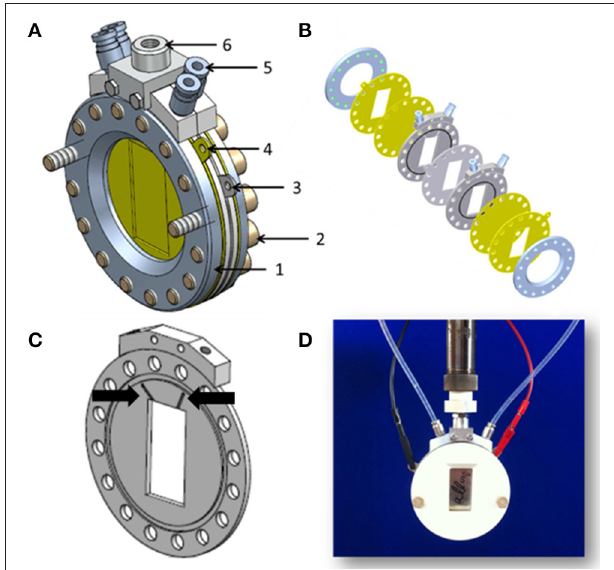
FIGURE 1 | (A) Expanded view of the in-situ cell; 1 and 2 correspond to the alloy clamp rings and PEEK screws used to seal the cell after assembly, 3 and 4 are the two windows which hold the thin Ni metal sheets used as positive and negative electrodes, 5 are inlet/outlet connections for the tubing to pump in gas fuel or electrolyte and 6 is the threaded block used to mount the cell on the diffractometer; (B) sketch of the cell components and their position with respect to the incident neutron beam; (C) close-up detail of the separator module; the two apertures that connect the inner compartment of the battery with the cell exterior (indicated by the black arrows); (D) assembled cell with tubing connections prior in-situ